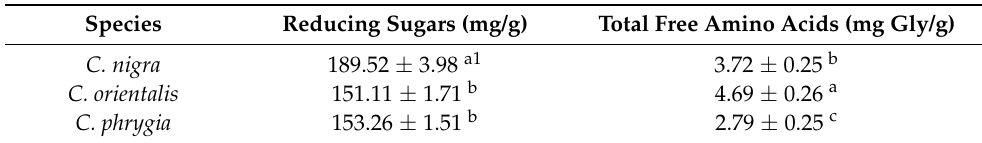
Table 3. Reducing sugars and total free amino acids of three Centaurea species. The data represent the mean ± standard deviation of three replicates.